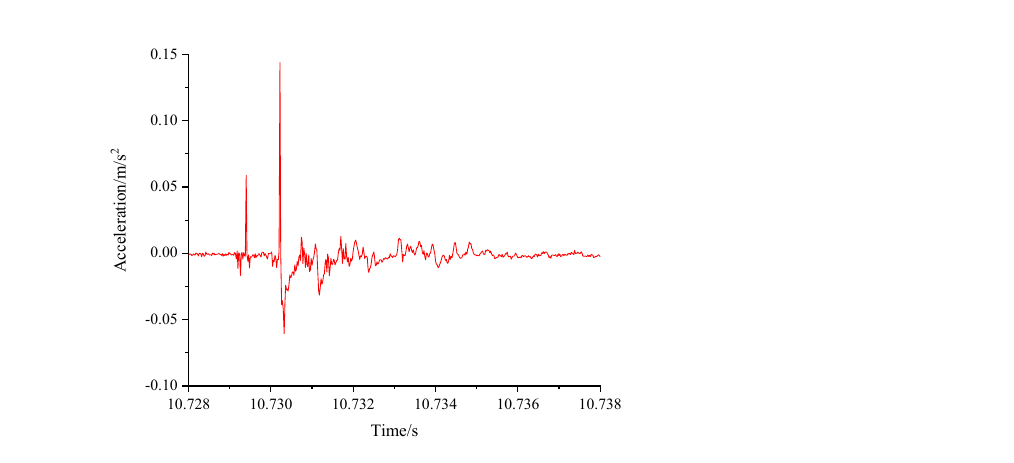
Figure 5. Vibration signal of the nominal operating condition during the auxiliary switch operation.